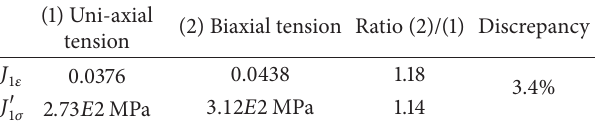
Table 5: Predicted maximum 𝐽 1𝜀 and 𝐽 󸀠 1𝜎 values under uni-axial and biaxial tension loadings—orientation 1.